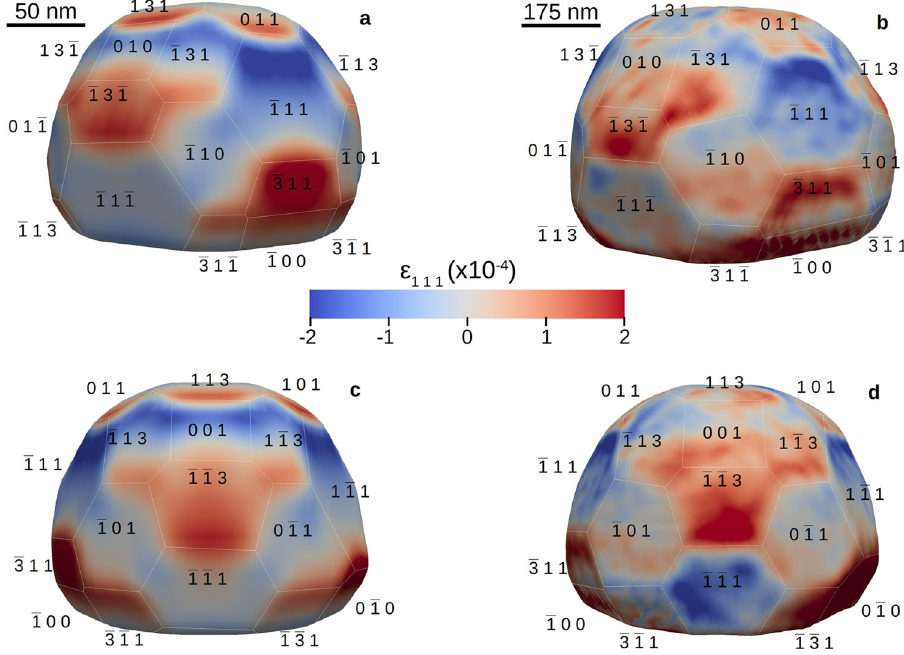
Fig. 4 Comparison between experiment and simulation for NP650. a , c 200 nm simulated NP with the same faceting as NP650 and relaxed by energy minimisation seen from two different fi eld of views ( b ), ( d ) Experimental ϵ 111 strain fi eld measured in Ar atmosphere for NP650 and seen from the same fi eld of